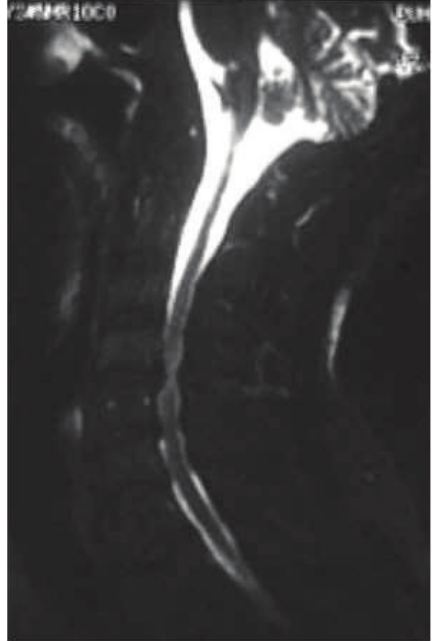
Figure 2: Lateral T2-weighted MRI of the cervical spine denoting significant spondylotic changes.